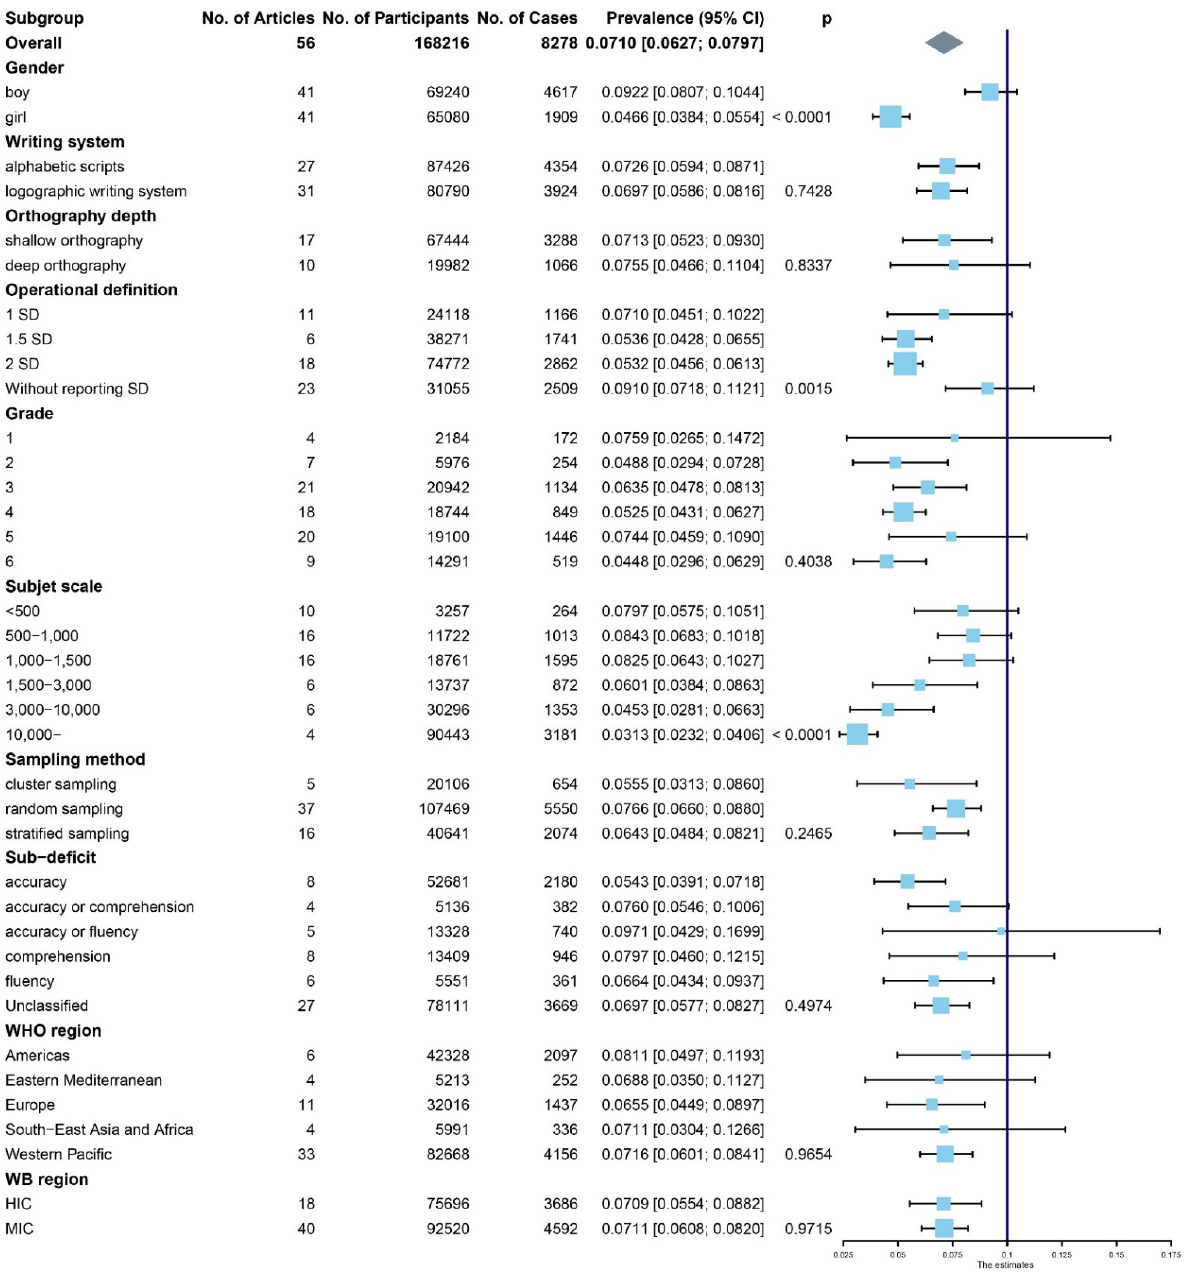
Figure 3. Forest plot for the subgroup meta-analysis of the prevalence of DD.